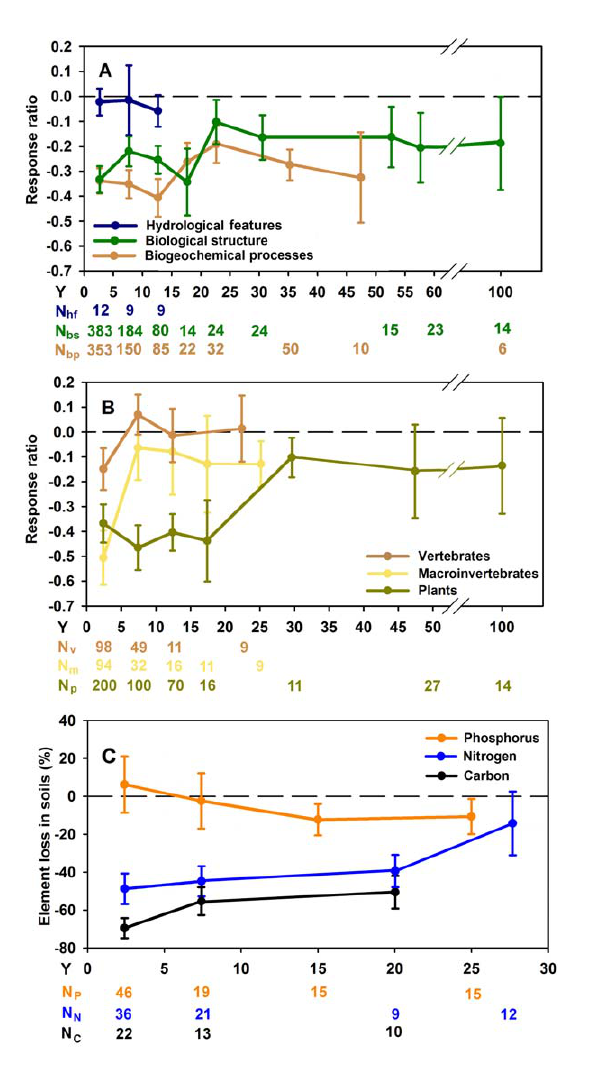
Figure 1. Recovery trajectories of created and restored wetlands. Chronosequences of the means ( 6 standard error [SE]) of the response ratios (see Materials and Methods) of restored and created wetlands at successive age classes of 5 y or 10 consecutive y for hydrology, biological structure, and biogeochemical functions (A) and for the main biological structural components (B). Chronosequences of the means ( 6 SE) of the element loss in soils of restored or created wetlands at successive age classes of 5 y or 10 consecutive y (C). The zero value dashed line represents reference wetlands. Only trend lines for those variables for which we had enough data points (see Materials and Methods) were plotted (N, number of data points used to calculate the mean [ 6 SE] per age class; Y, years after restoration. Subscripts are as follows: bp, biogeochemical processes; bs, biological structure; C, carbon; hf, hydrological features; m, macroinvertebrates; N, nitrogen; p, plants; P, phosphorus; v, vertebrates).